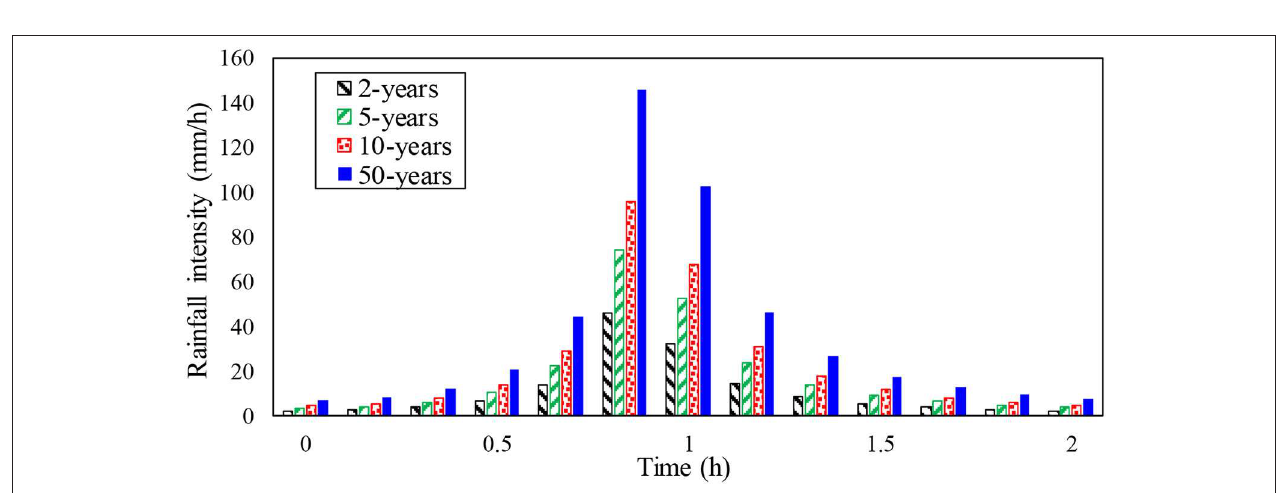
FIGURE 6 | Rainfall process diagram and volume process diagram under different scenarios.